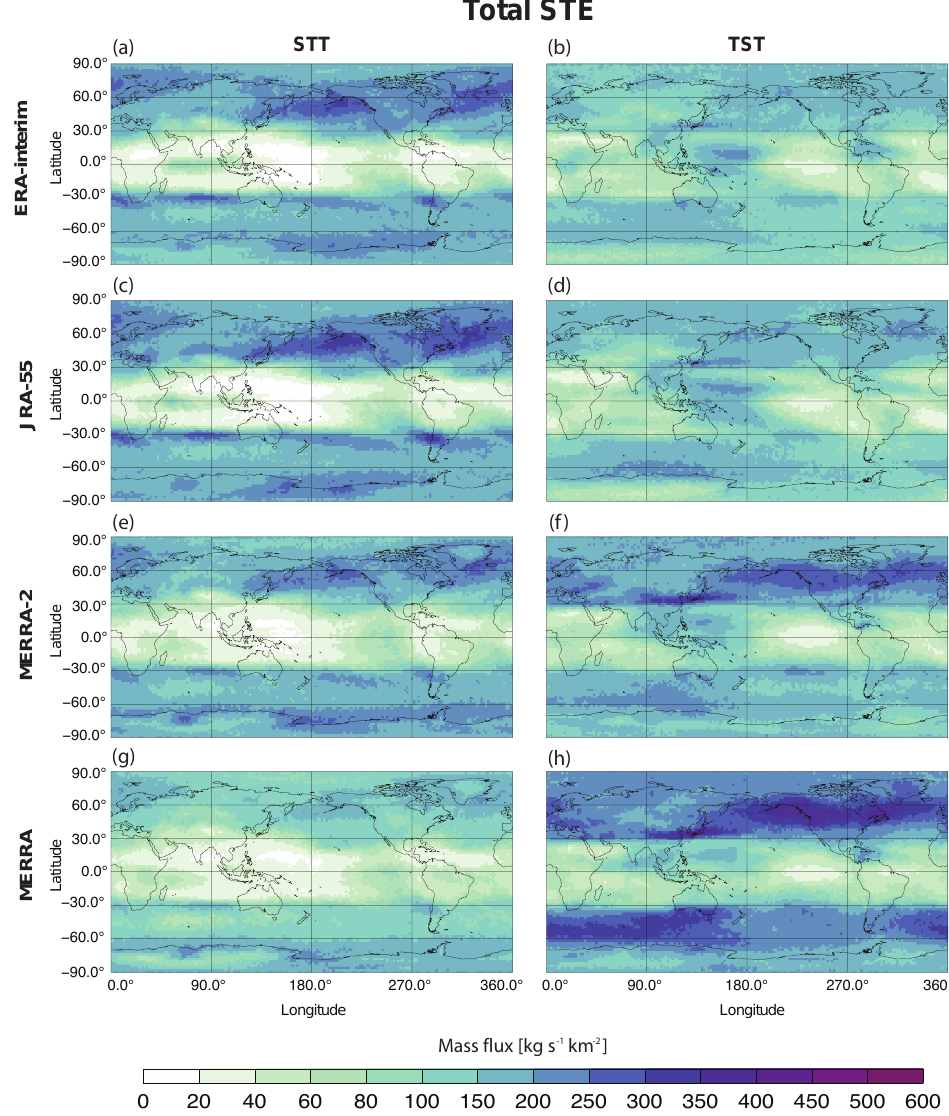
Figure 4. Annual mean geographic distributions of total (sum of tropical, subtropical, extratropical) STE mass flux for ERA-Interim (a, b) , JRA-55 (c, d) , MERRA-2 (e, f) , and MERRA (g, h) . STE is separated into STT (left) and TST (right) for each